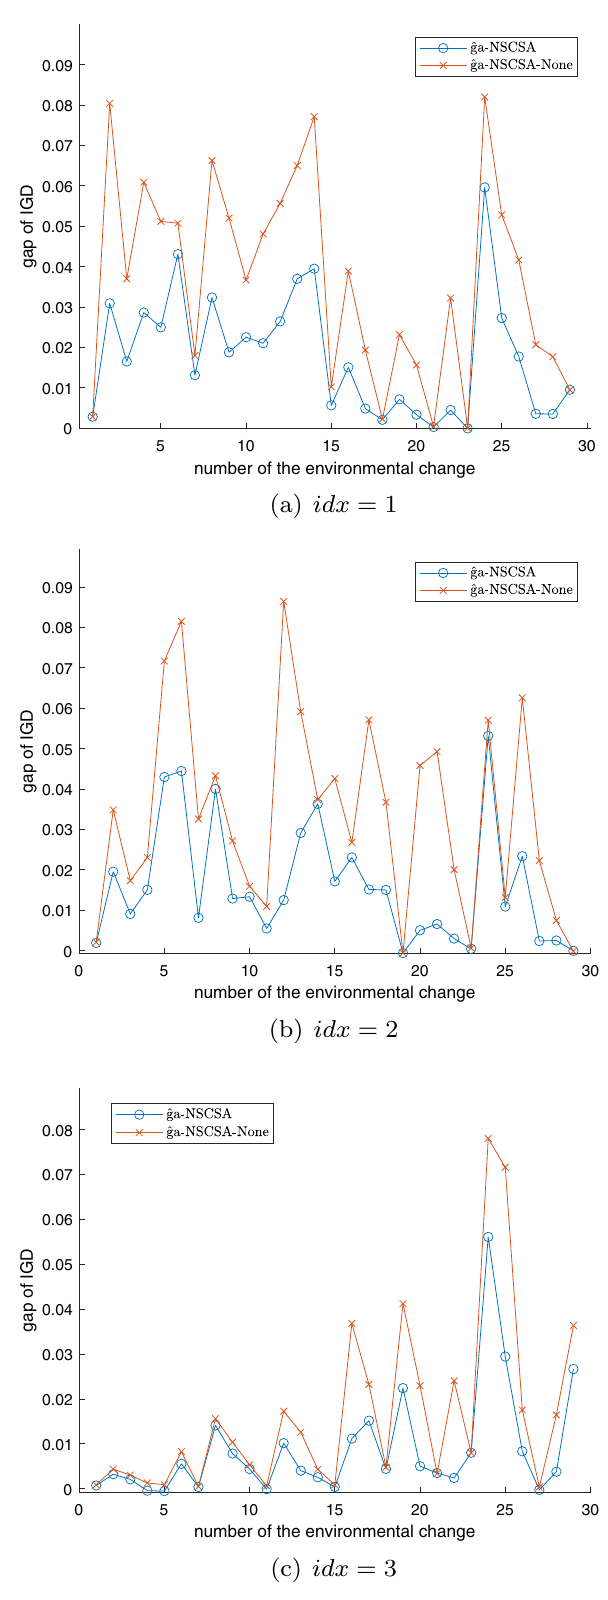
Fig. 8 The gap of IGD before and after moving reference point in